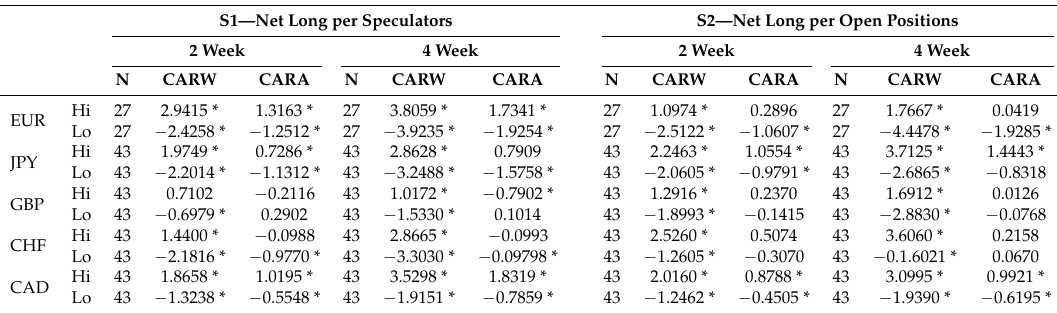
Figure 2. Event Study: Extreme (Low 10th percentile) Risk Reversal Skew and 16 day event window: Risk reversals are the ratio of implied volatility on calls to the equivalent put; extreme low is at or below the 10th percentile for the whole range, cumulative returns are the sum of log exchange rate returns. The event day is the day of the extreme risk reversal reading. If speculation is uninformed, extremes should be followed by reversals; if speculation is informed, extremes are more likely to be followed by a random walk. The solid line is the cumulative mean return from the start of the event window; the dashed lines show the 95% confidence intervals constructed from 1000 random bootstrap samples of appropriate event window day. Table 2. Event Study: Cumulative Abnormal Returns and Extreme Speculative